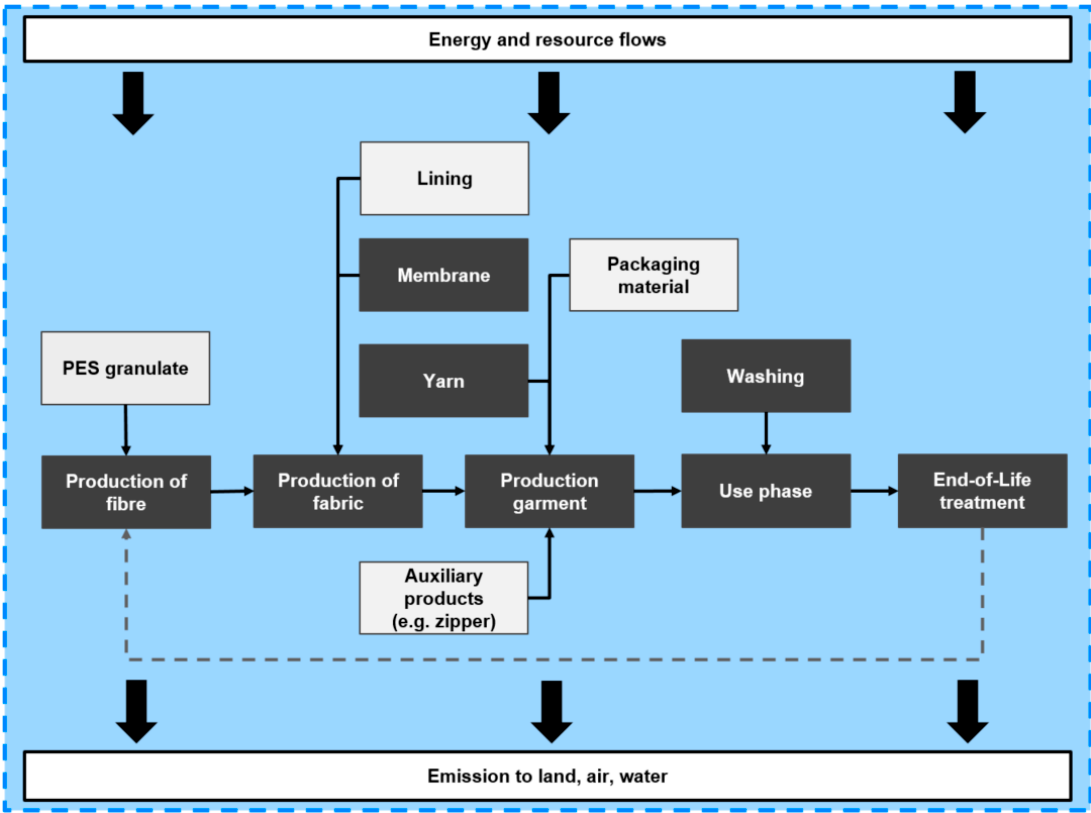
Figure 1. The system boundaries as set for this study. All the life cycle stages are included for the production of a three-layer laminate jacket. For the black boxes, primary data is collected directly from the partner companies. For the four grey boxes, secondary data from the ecoinvent database is utilized together with assumptions made by the partner companies (e.g., how much packaging is required) because primary data from the corresponding subcompanies are not (entirely) available.